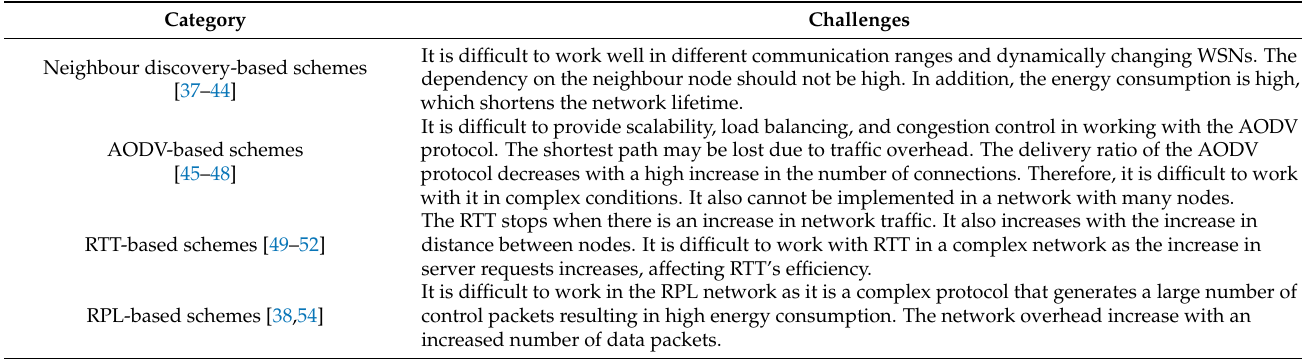
Table 7. Identified challenges of wormhole detection